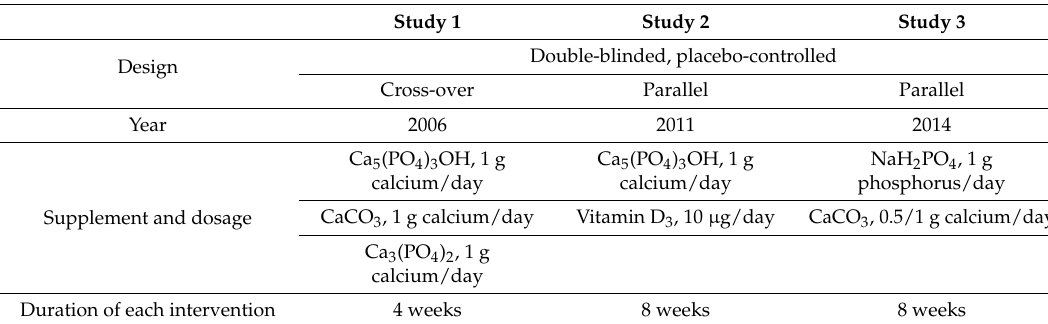
Table 1. Overview of study design characteristics.